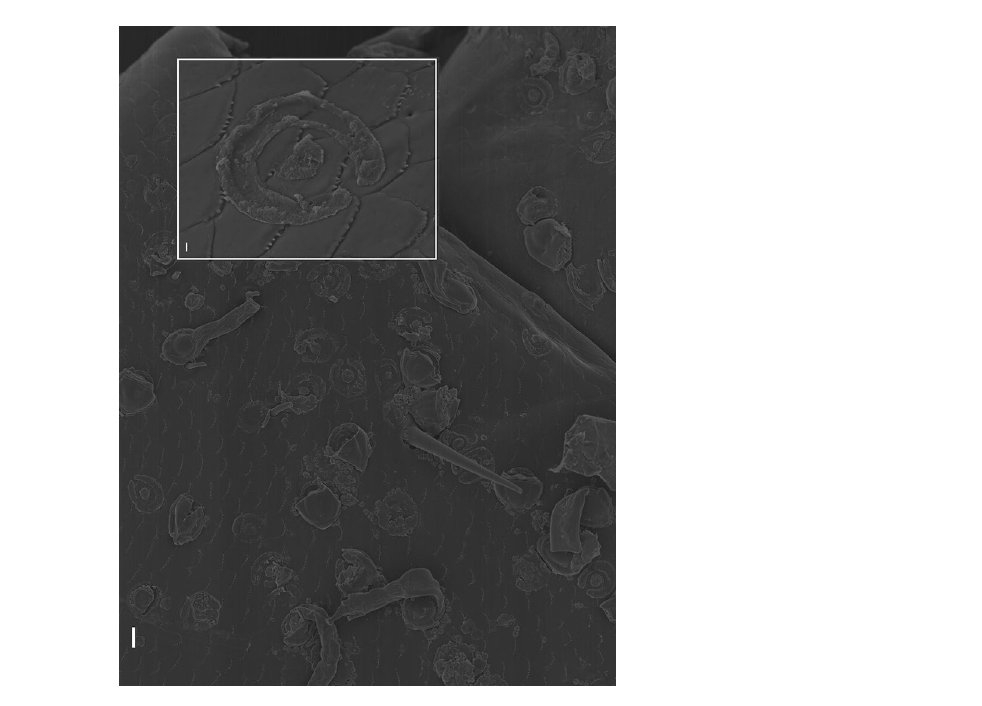
Figure 3. SEM image of detached Rickia gigas on the cuticle of the millipede Tropostreptus hamatus . Scale bars: 10 μm in overview image, 1 μm in detail